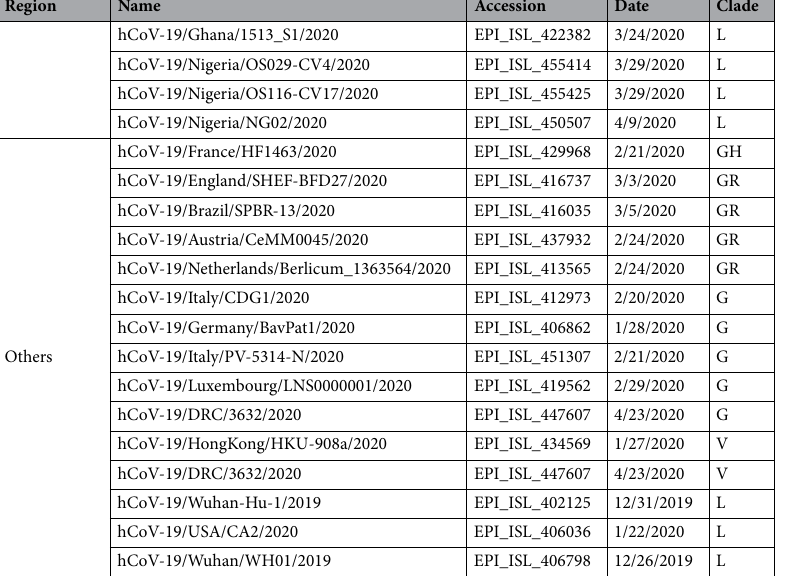
Table 1. SARS-CoV-2samples used for the phylogenetic